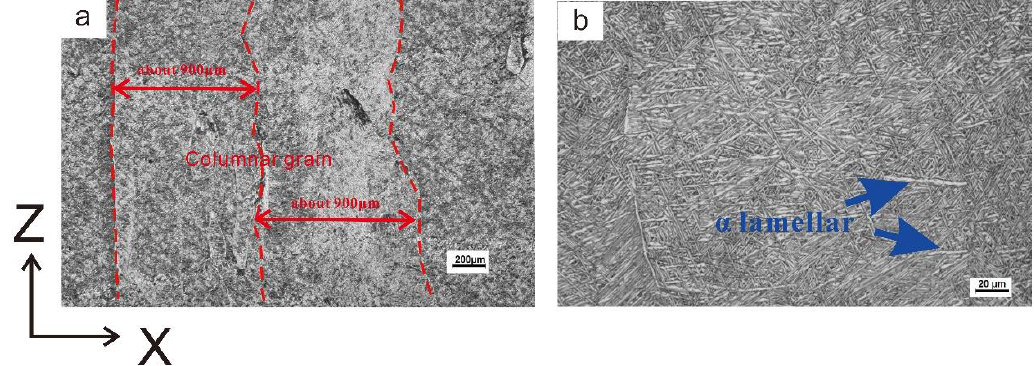
Figure 2. Microstructure of laser metal deposition (LMD) Ti-6.5Al-2Zr-1Mo-1V, ( a ):50X; ( b